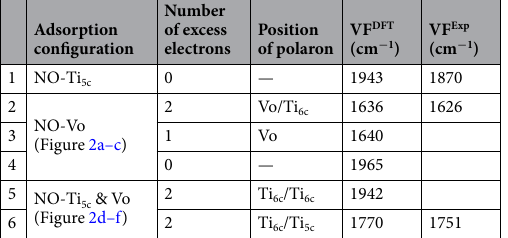
pre-adsorbed with adequate O 2 at 90 K and subsequently exposed to 0.01 L NO. In this case, both 1626 and 1751 cm − 1 bands no longer occur in the spectra (See Figure S1 in the SI), while new 1874 cm − 1 and 1743 cm − 1 bands appear. The latter two bands correspond to the symmetric and asymmetric stretching vibrations of (NO) 2 dimer adsorbed on surface Ti 5c sites 38 . Contrary to CO, saturatedly adsorbed O 2 molecules occupy all the Vo sites and collect all the excess electrons of reduced TiO 2 (110) surface at low temperature 15 . The absence of 1626 cm − 1 and 1751 cm − 1 bands convincingly indicates that both bands should be related to the excess electrons. DFT calculations were performed based on a 2 × 4 supercell to further clarify the adsorption configuration of NO and the role of polarons in molecular adsorption by means of comparing the calculated vibrational frequency (VF) of NO (see Table 1) with the experimental values. To verify the feasibility of the theoretical approach, we firstly calculated the distribution of polarons on the pristine TiO 2 (110) surface with one Vo. The lowest energy state among all possible polaron distributions corresponds to the case that two polarons are respectively localized at two nearest-neighboring Ti 6c sites in the subsurface from Vo (See Figure S2 in the SI), which is in good agree- ment with previous reports 39–41 . Furthermore, the calculation shows that the parallel spin alignment of two polar- ons and the antiparallel one are almost degenerate in energy, suggesting the weak exchange interaction between two polarons. This is also consistent with the recent calculation results 42 . When one NO molecule adsorbs at Vo sites and none of the surrounding Ti 5c cations is occupied, named con- figuration NO-Vo, as shown in Fig. 2a and b, the binding energy (E b ) of NO molecules adsorbed at Vo is 1.09 eV. In this case, the calculated VF is 1636 cm − 1 (2th entry), in good agreement with the experimental IR value (1626 cm − 1 ) but markedly lower than that (1943 cm − 1 ) of isolated NO adsorbed on defect-free surface (1st entry of Table 1) with E b of 0.61 eV. The calculated density of states (DOS) is shown in Fig. 2c. Within the band gap, there